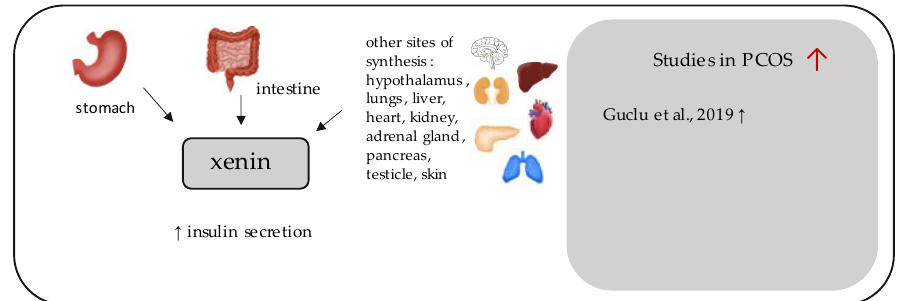
Figure 9. Role of xenin in the pathogenesis of insulin resistance and PCOS. List of the studies assessing xenin in serum of the patients with PCOS. ↑ indicates that concentration level of xenin was increased in PCOS individuals ( p < 0.05).